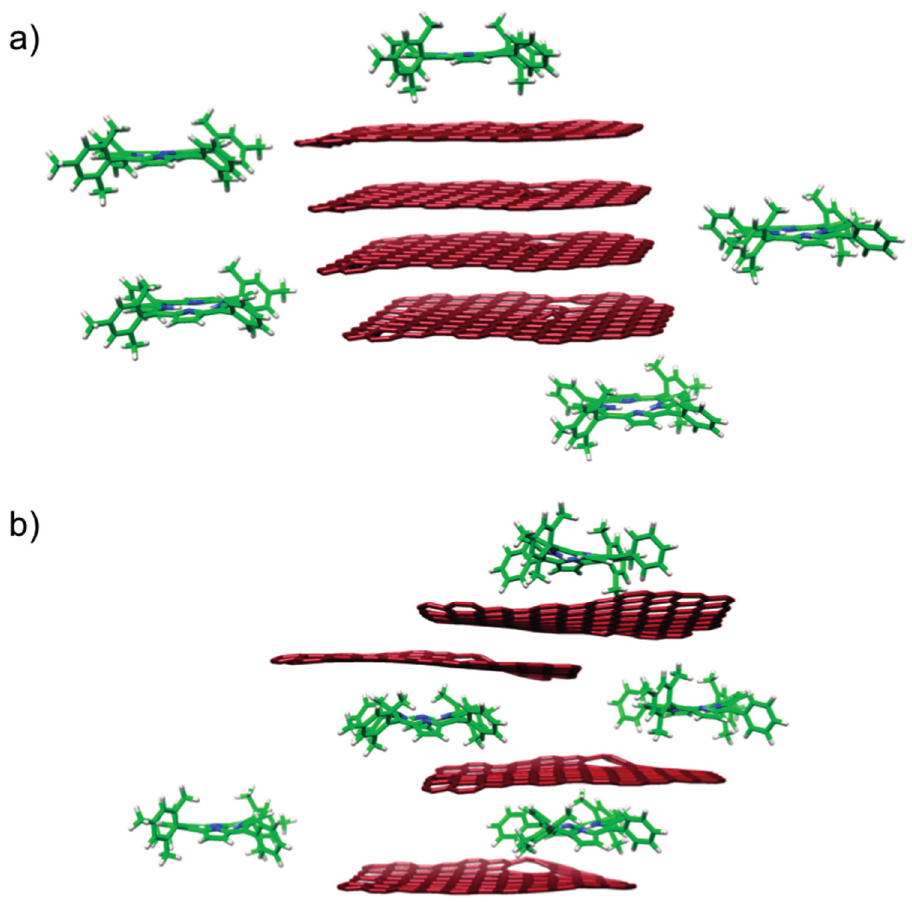
Figure 1. Cartoon representation of the exfoliation mechanism to produce few layer graphene (FLG)/porphyrin hybrids: ( a ) Addition of graphite to porhyrin solution; and ( b ) Porphyrin molecules exfoliate graphene sheet to produce FLG/porphyrin